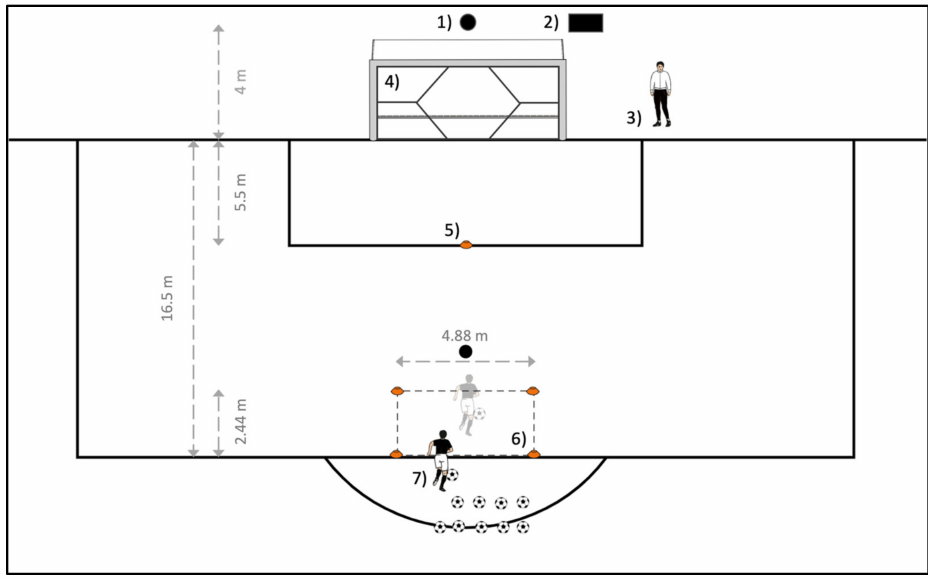
Figure 2. Test set-up for the shooting test. (1) Radar sensor, (2) Speed indicator of the radar sensor, (3) Test administrator with evaluation sheet, (4) Target net, (5) Marker of the maximum shot speed test, (6) Shooting area for target shots, (7) Starting position of the